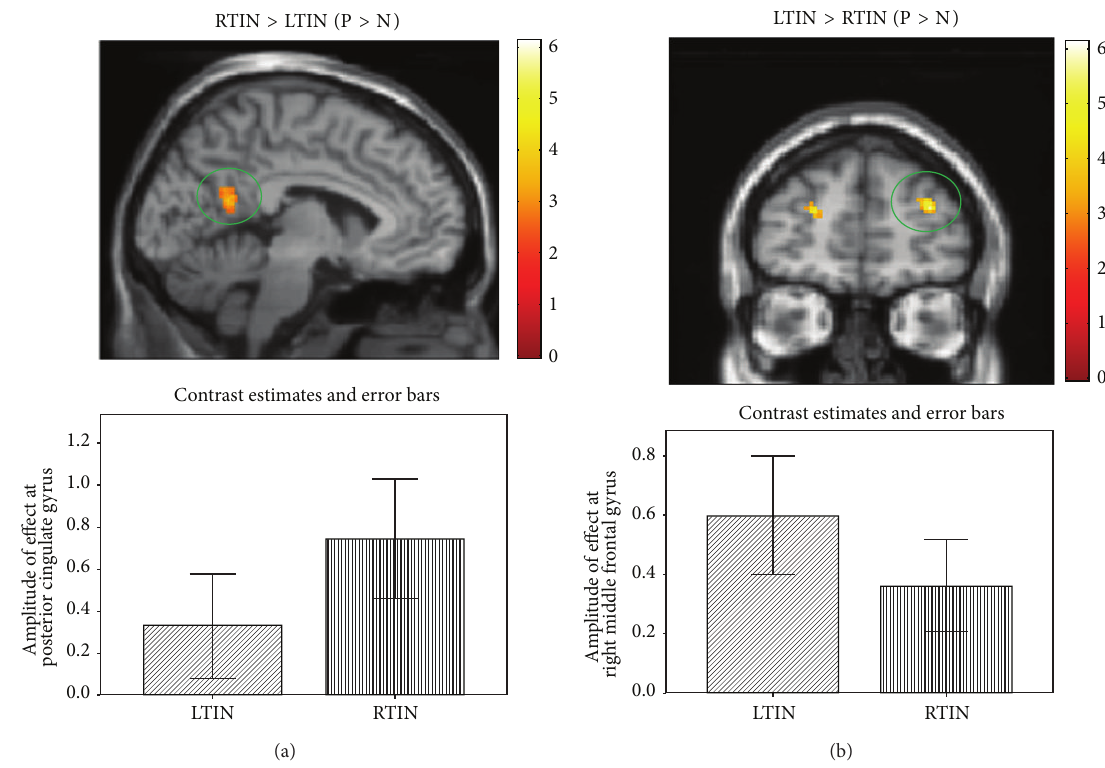
Figure2:Statisticalparametricmapsforposthocindependentsample 𝑡 -testsfortheemotiontask.Whole-brainposthocindependentsample 𝑡 - tests were used to determine group differences. (a) Statistical tests detected increased response in the posterior cingulate in the RTIN group compared to the LTIN group. (b) Statistical tests detected increased response in the right middle frontal gyrus in the LTIN group compared to the RTIN group. For better visualization, the maps are displayed at 𝑝 < 0.001 uncorrected, but the circled cluster is corrected for multiple comparisons ( 𝑝 < 0.025 FWE). Table 6: Local maxima for the region-of-interest (ROI) independent sample 𝑡 -tests in the emotion task experiment. Between-group independentsample 𝑡